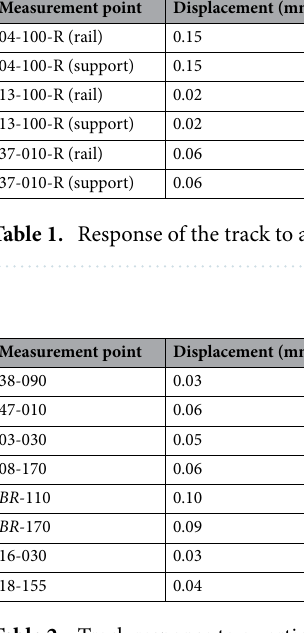
Table 2. Track response to a vertical load of 200 N applied in different